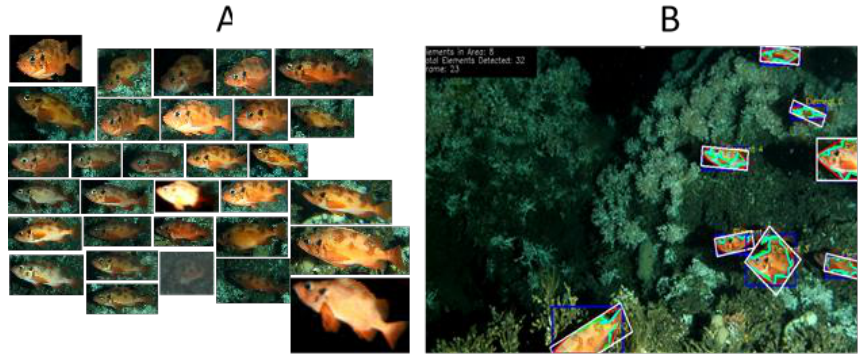
Figure 9. ( A ) A set of images from a larger training library as an example of supervised tracking and classification of Rockfish ( Sebastes sp.) within a constant field of view from archived videos at LoVe. ( B ) Results of automated tracking and counting of individuals passing by, as evidenced in a video by the recognition boundary boxes (see Supplementary Video S1).